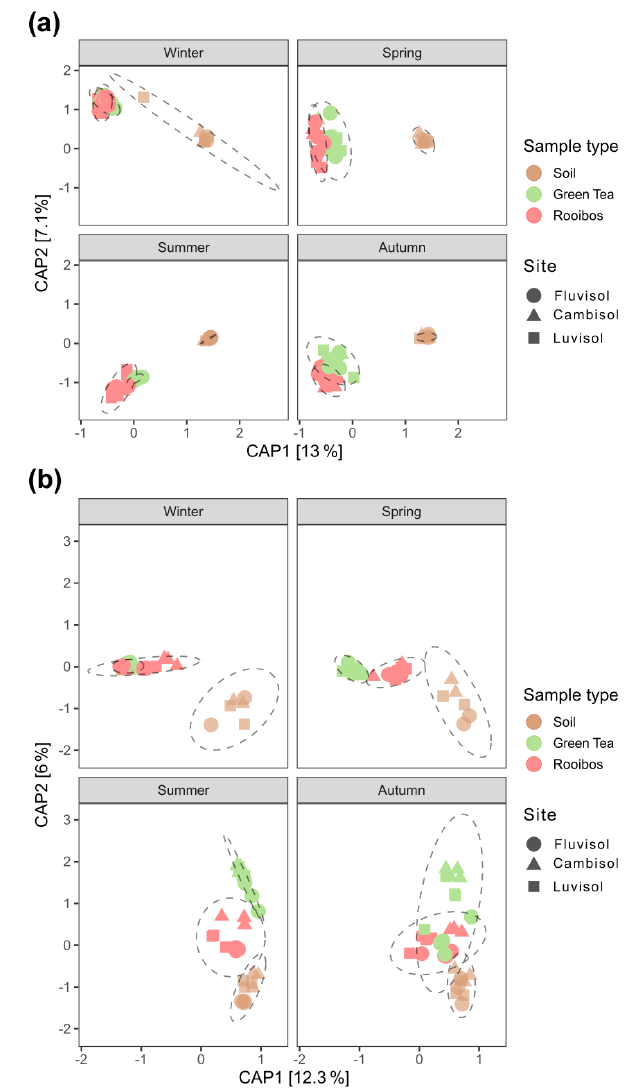
Figure 3. Principal coordinate analyses plots of prokaryotic (a) and fungal (b) community compositions based on Morisita–Horn dis- tances of 16S rRNA gene and ITS region ASVs derived from soil, green tea, and rooibos teabags. The models were obtained using the formula: distance matrix ∼ field + sample type ×